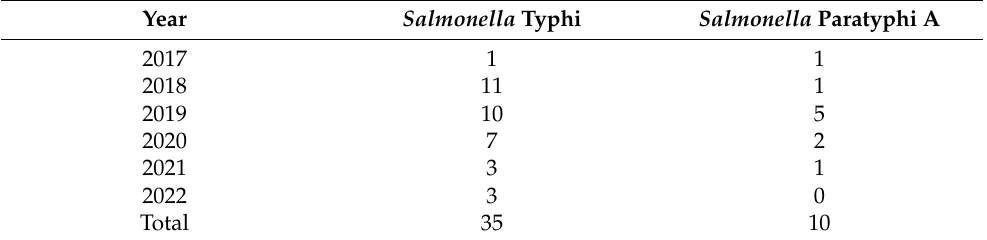
Table 3. Number of Salmonella Typhi and Salmonella Paratyphi A isolates that were obtained in each year from 2017 to 2022.